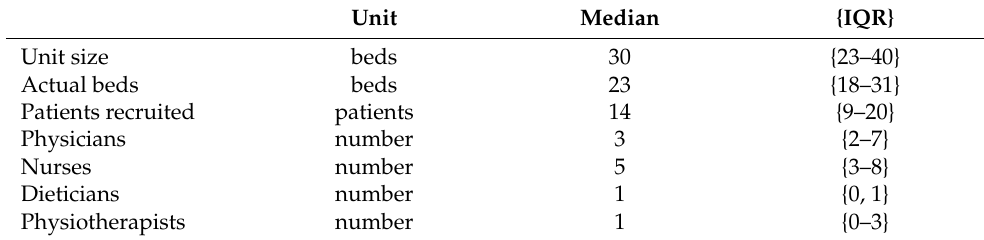
Table 1. Unit characteristics ( n = 2793) from 58 countries.